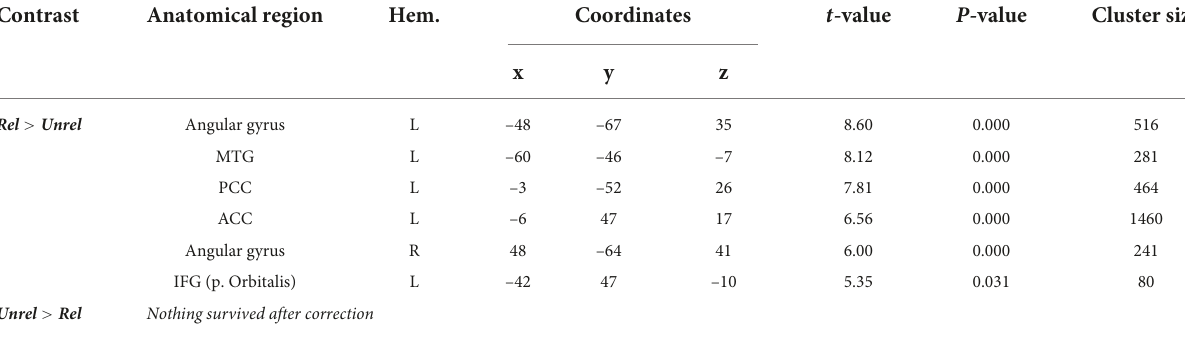
TABLE 2 Related vs. Unrelated during encoding: Peak coordinates of significant clusters.